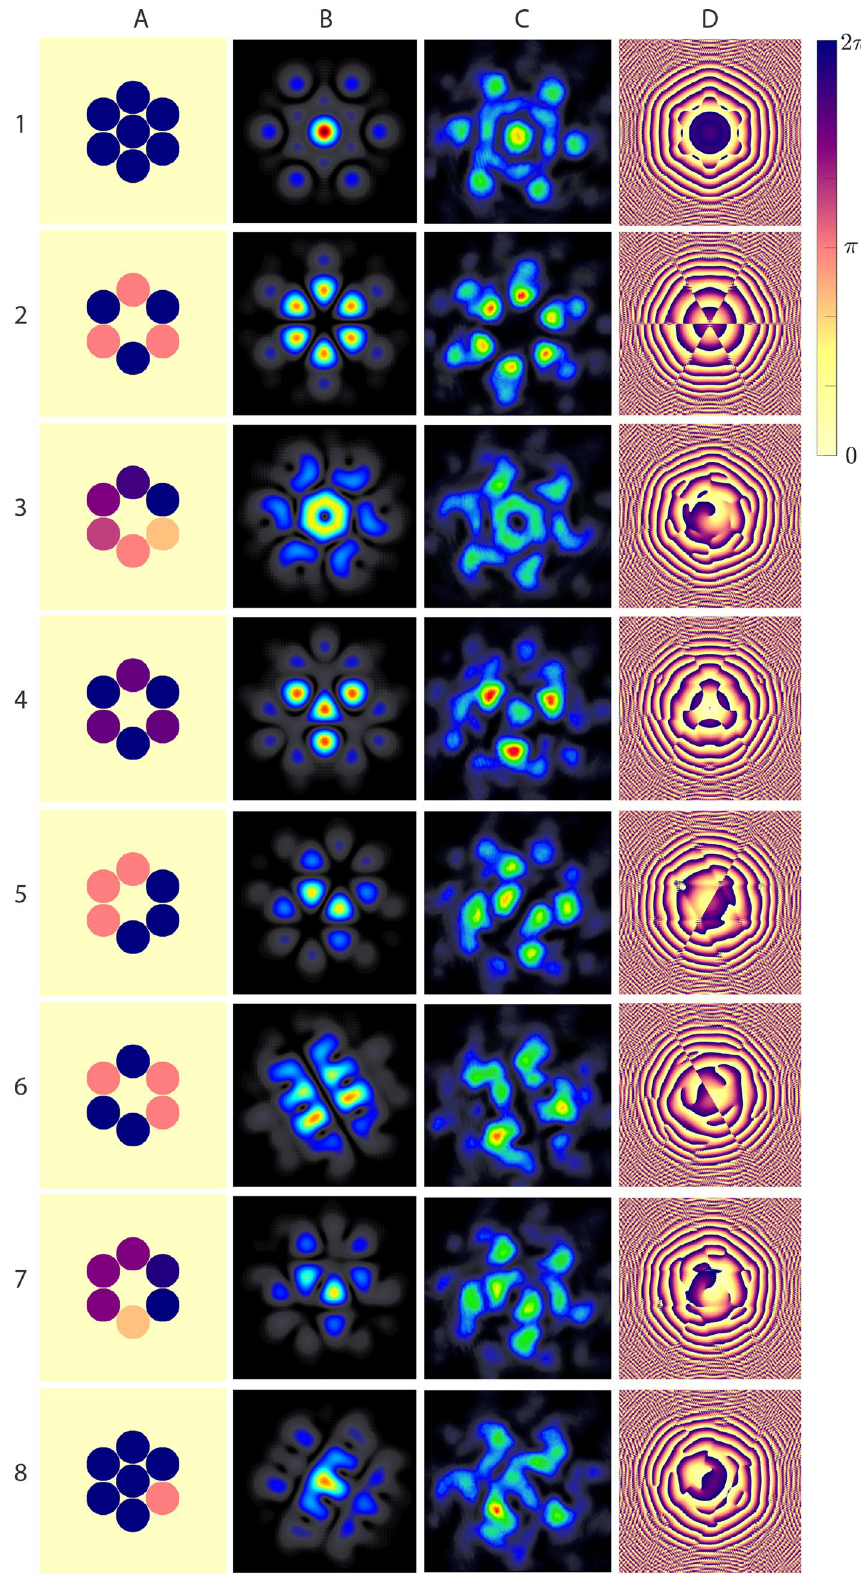
Figure 2. Near-field phase- and amplitude combinations (column A ) and their corresponding retrieved (column B ) and measured synthesized far-field intensity (column C ) and phase distributions (column D